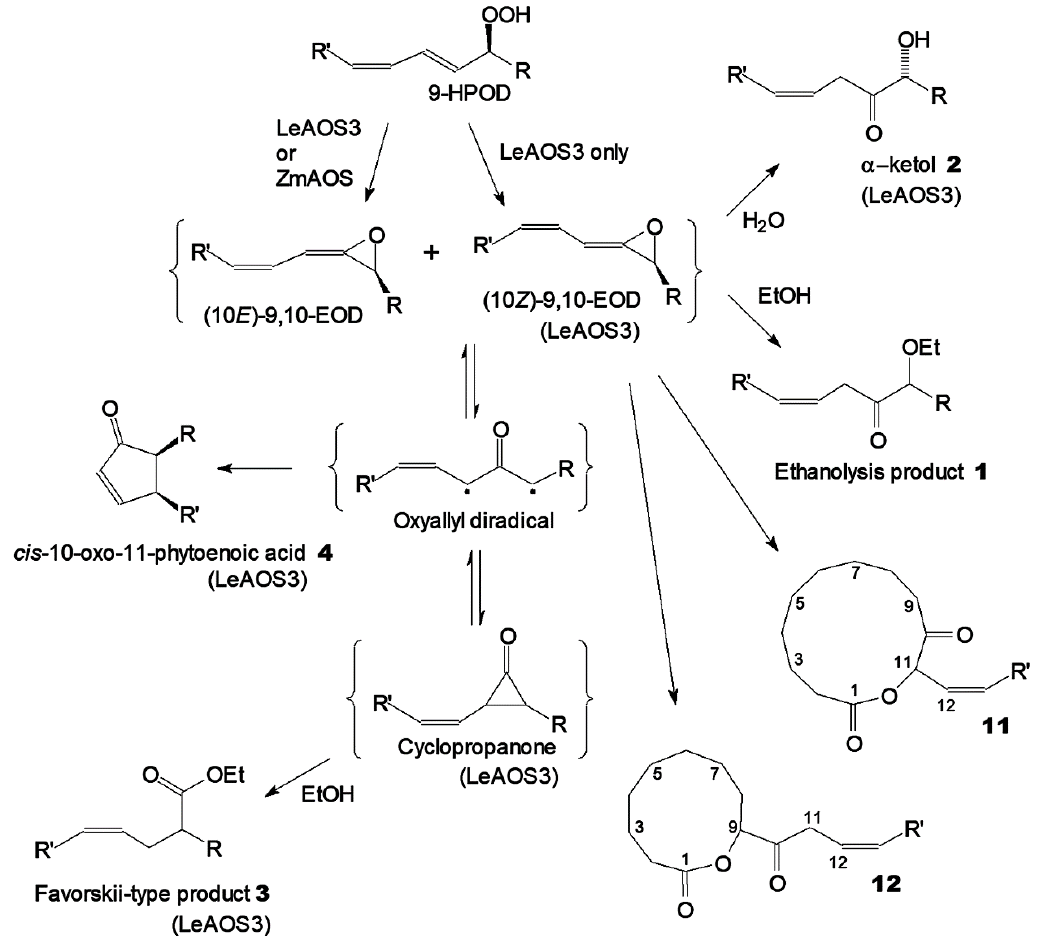
Figure 7. Scheme of 9-HPOD conversions to various products in the presence of LeAOS3 or ZmAOS followed by either ethanol trapping (all products except 11 and 12 ) or keeping allene oxide in hexane (products 11 and 12 ). R = -(CH 2 ) 7 COOH; R ′ = -(CH 2 ) 4 Me. The inscription (LeAOS3) in brackets under the names of separate products means that these products were formed only or predominantly with LeAOS3, not with ZmAOS.